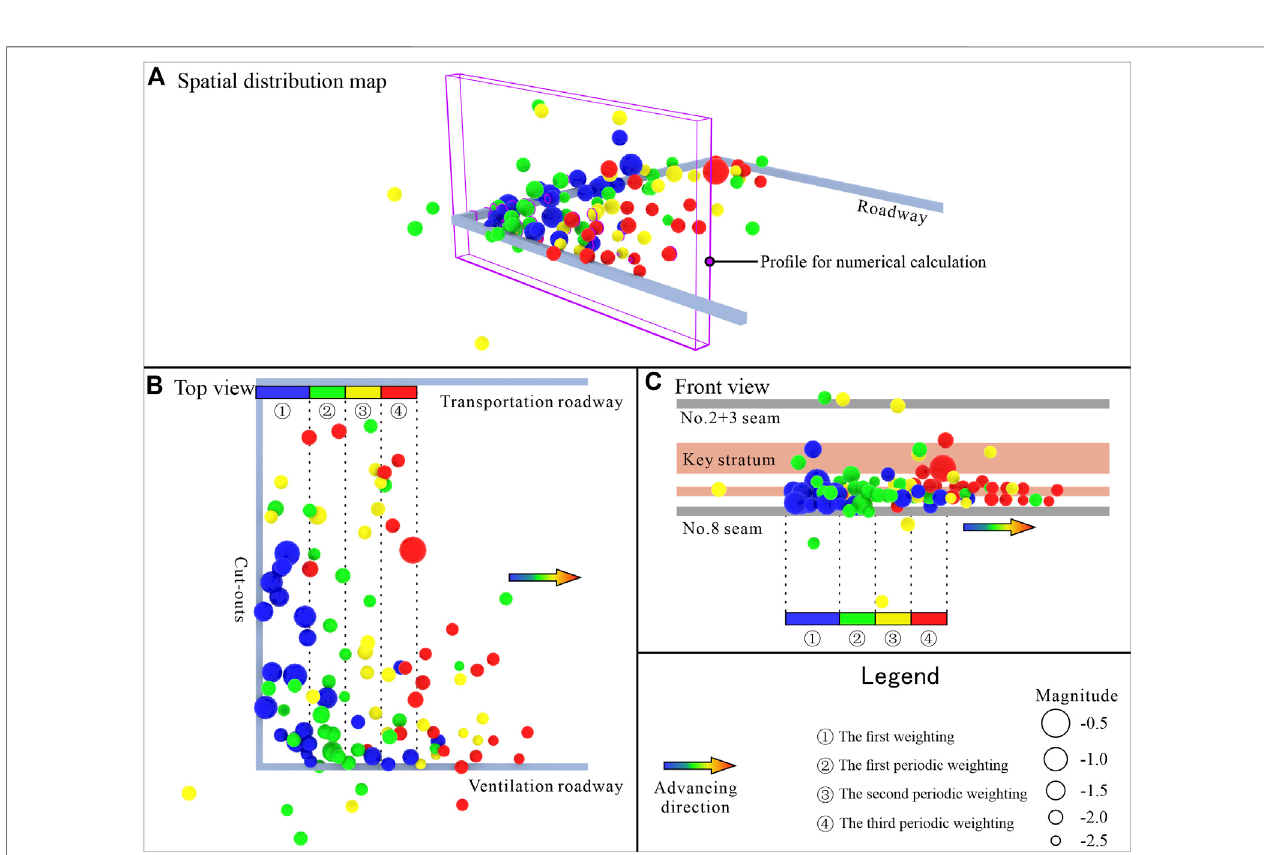
FIGURE 3 | Distribution of microseismic events of the No. 18401